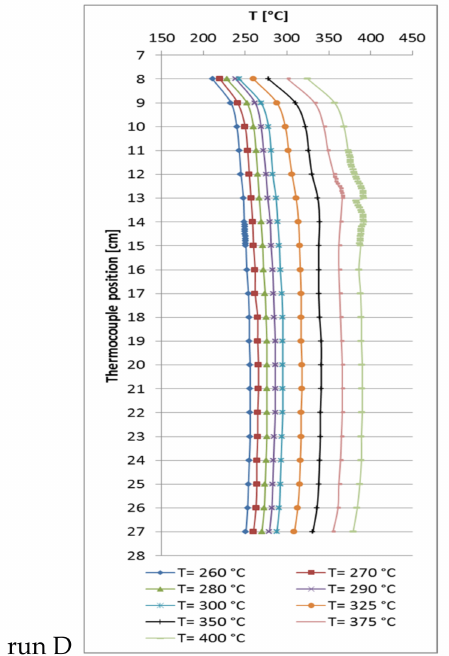
Figure 3. Recorded temperature profiles for methanation on 18Ni/Al 2 O 3 with 0.5 mL catalyst + 4.5